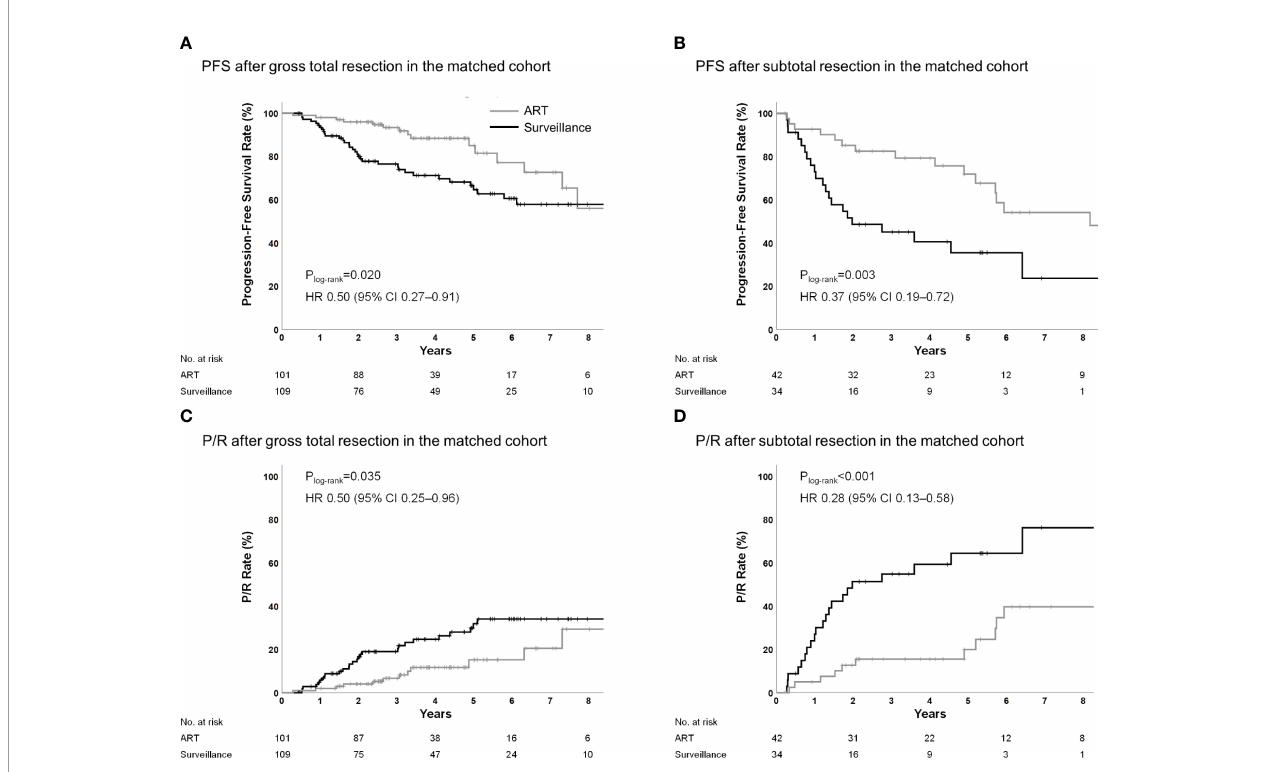
FIGURE 2 | PFS and P/R for ART according to surgical extent in the propensity score-matched cohorts. ART, adjuvant radiotherapy; PFS, progression-free survival; P/R,